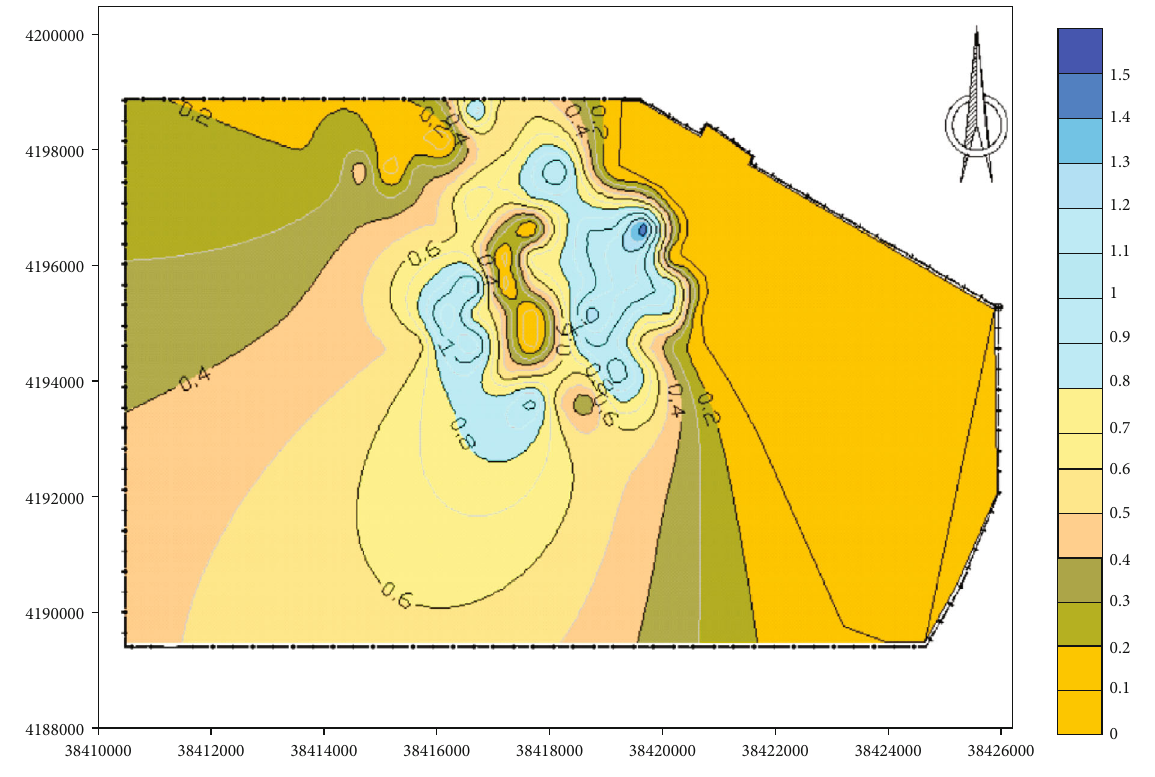
Figure 7: Thematic map of the fractal dimension value of the collapse column.